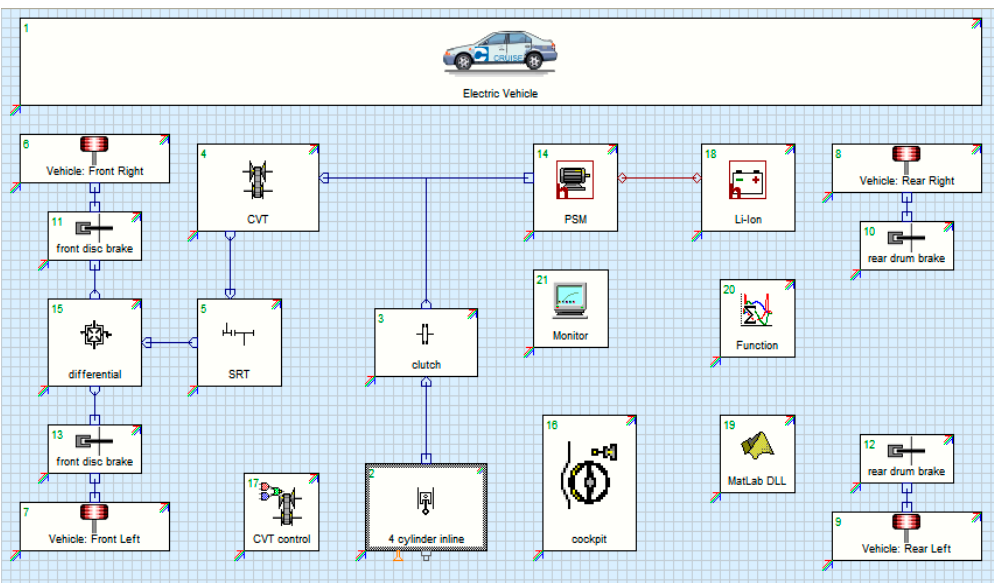
Figure 2. The designed PHEV model in AVL Cruise.